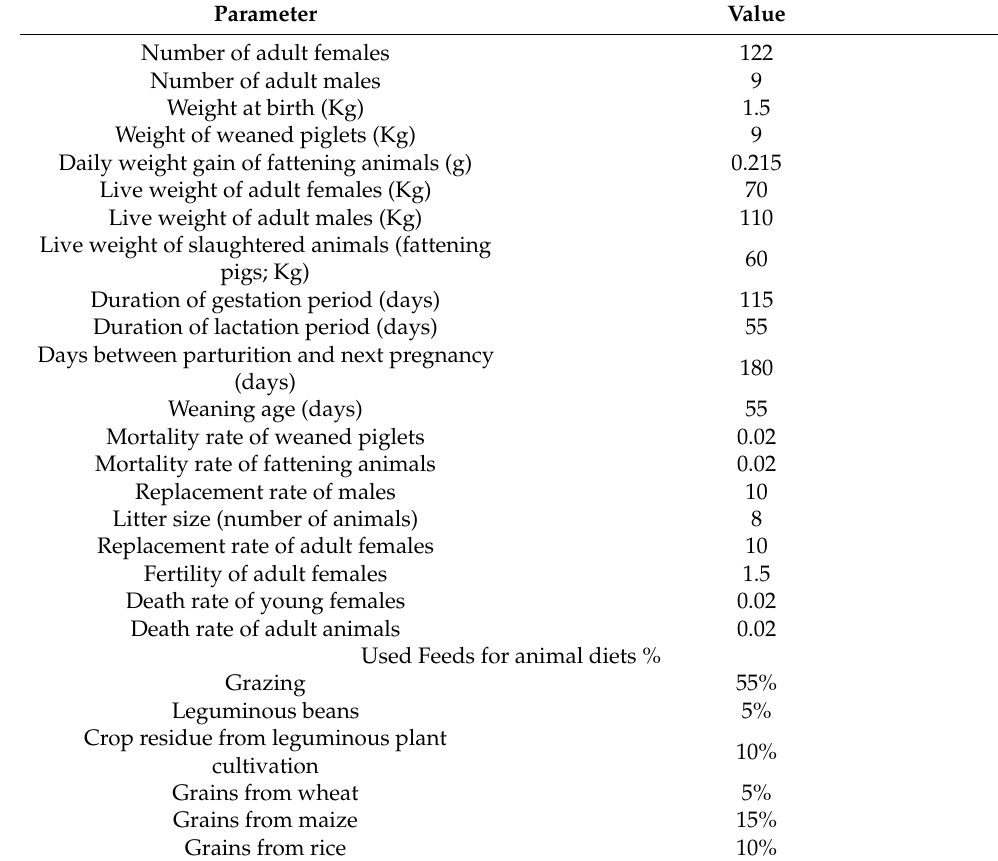
Table 1. Characteristics of the studied semi-extensive pig